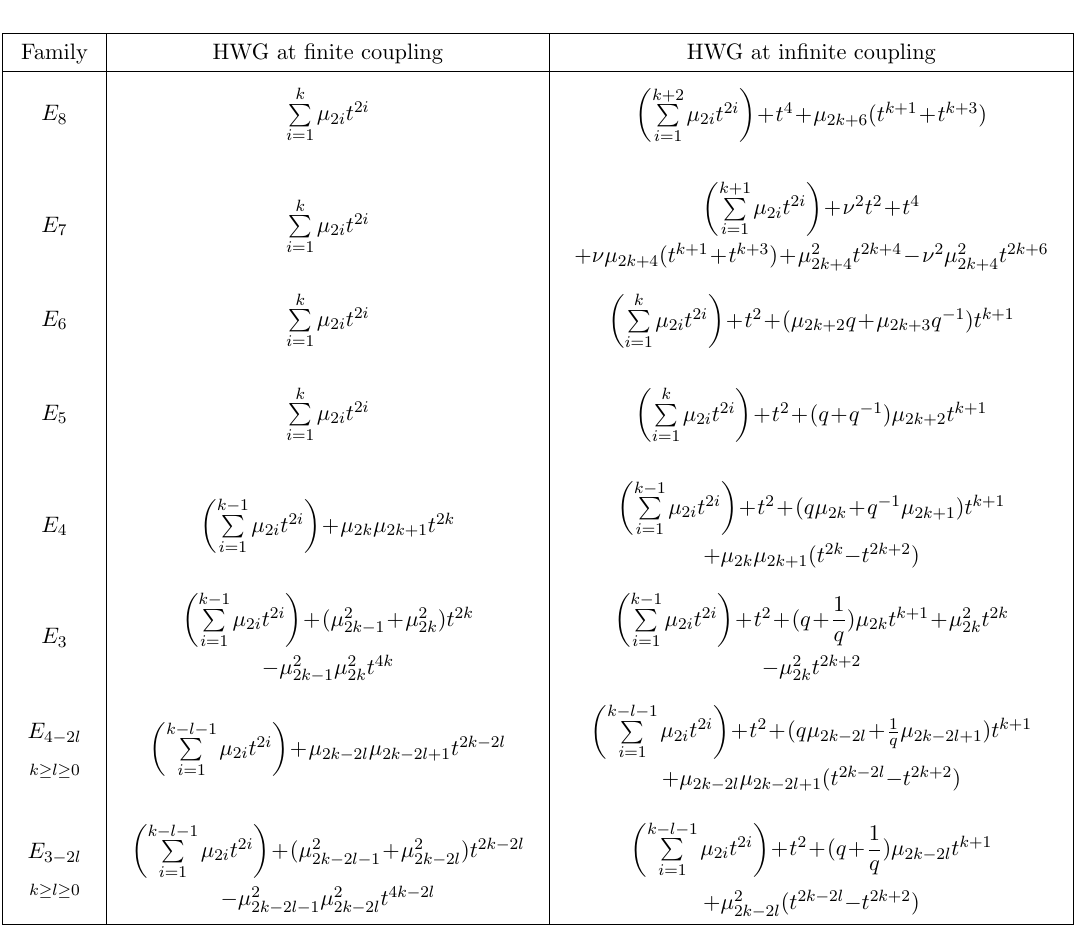
Table 4 . Highest weight generating function (HWG) [82, 83] for the orthogonal exceptional families. The highest weight fugacities are assigned as follows: (cid:22) i for so , (cid:23) for su (2), and q for u (1). The along the 3d = 4 Coulomb N